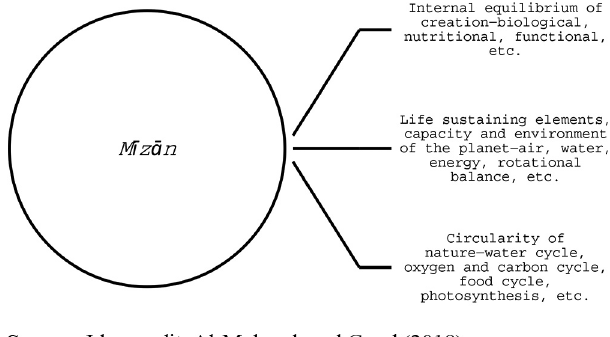
Figure 3. Summary